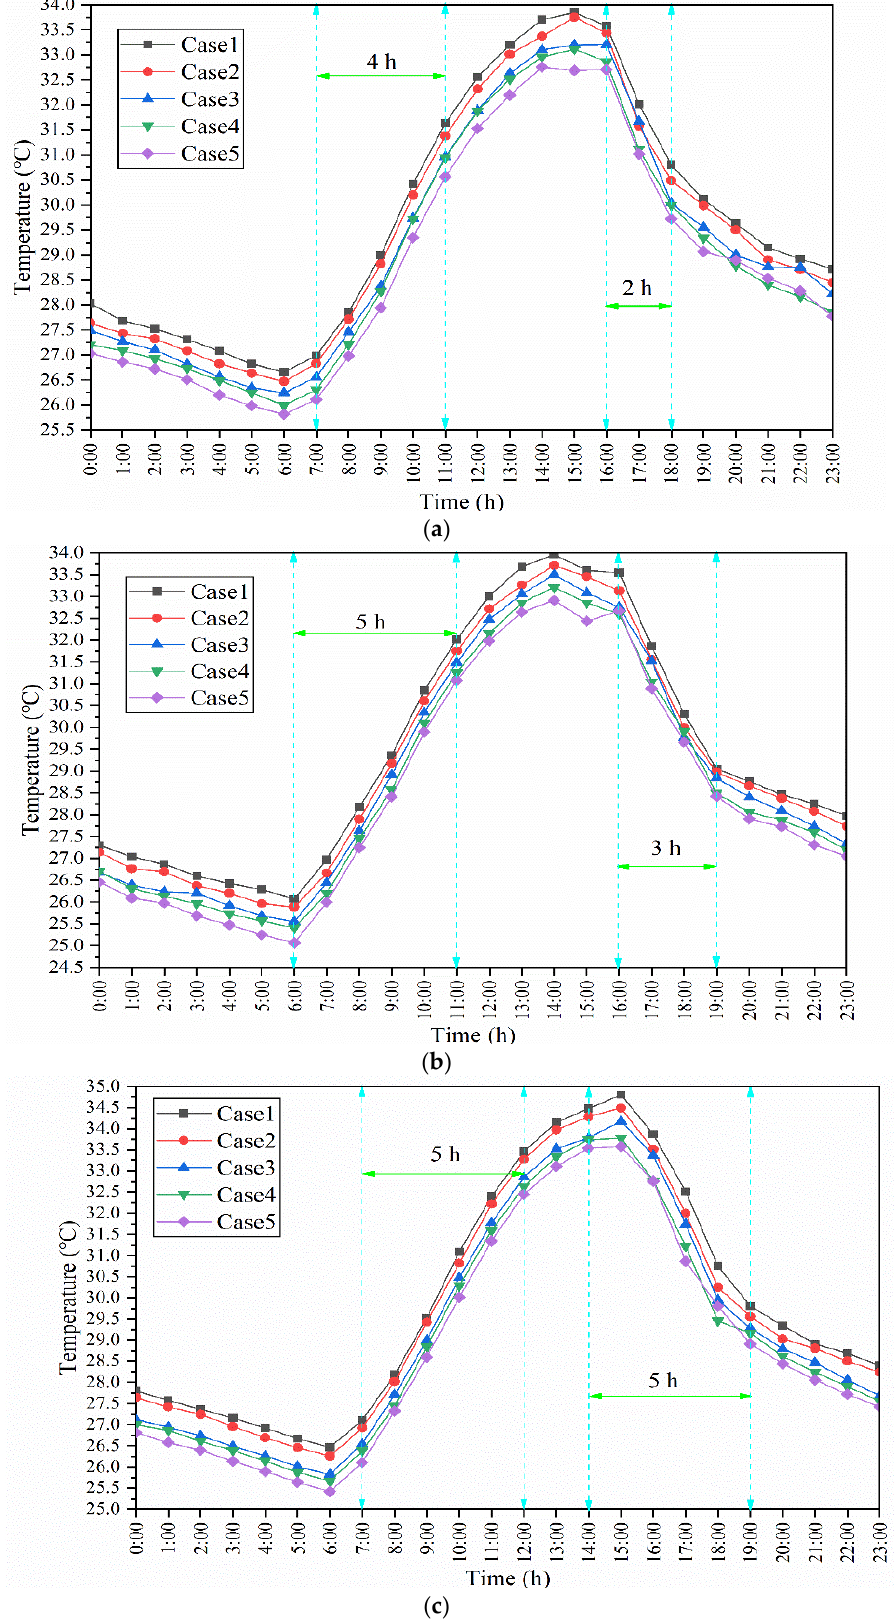
Figure 6. Daily air temperature variation in the ( a ) business, ( b ) residential, and ( c ) industrial areas.